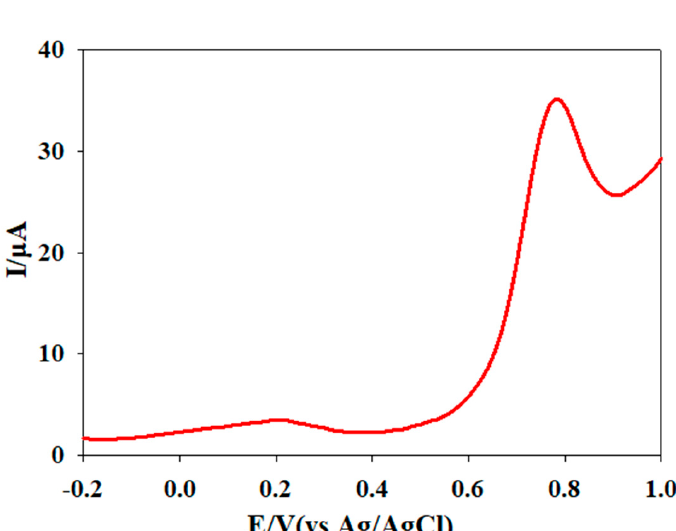
Figure 9. Square wave voltammogram of 0.1 mM MTX + 50 µ M ascorbic acid in pH 7.0 BR buffer at a scan rate of 100 mV s − 1 using g-CN /CPE.